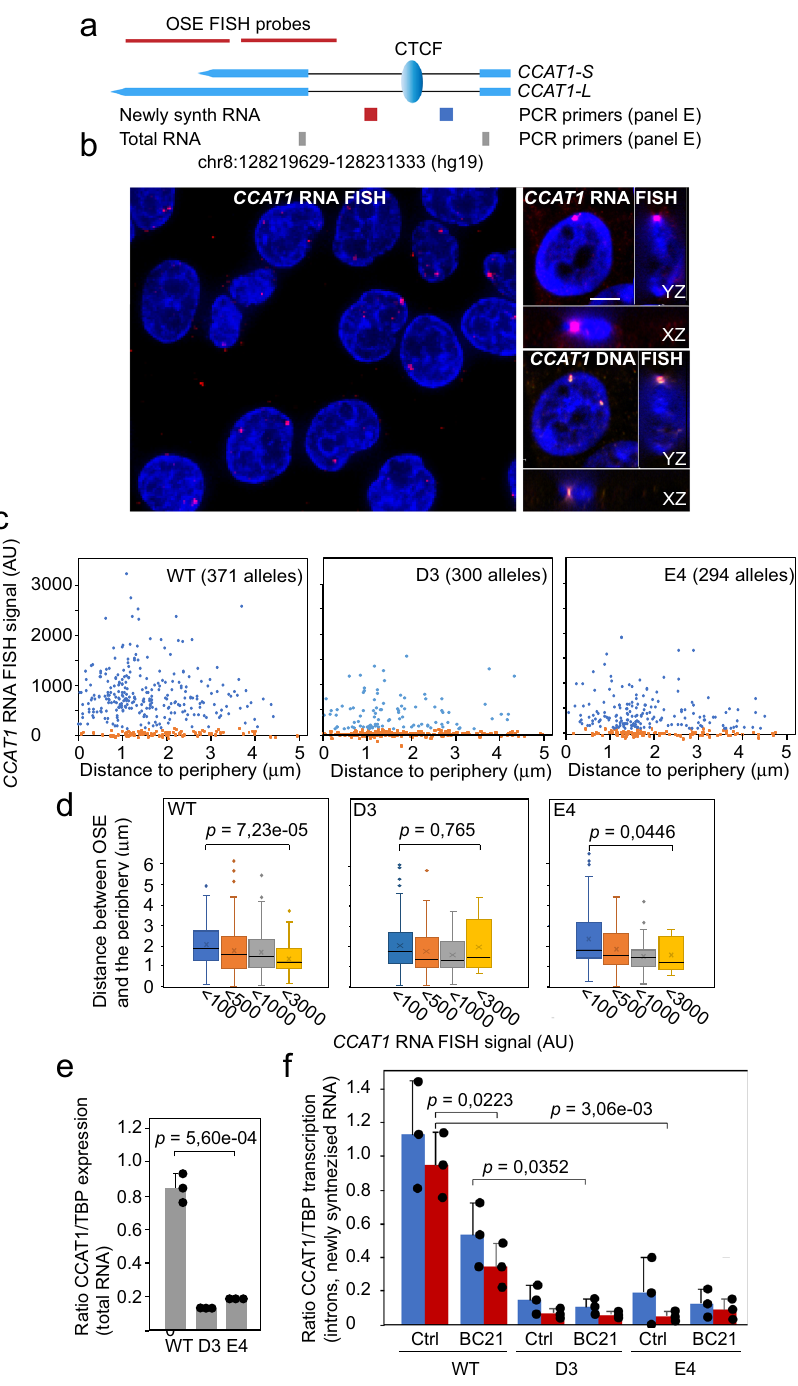
Fig. 6 WNT activates CCAT1 eRNA expression via the CTCFBS to promote its juxtaposition to the nuclear periphery. a Schematic map of the CCAT1 gene and the position of the CTCFBS and the primers used to assess CCAT1 expression. b Sequential RNA/DNA FISH analyses to score for CCAT1 expression in WT HCT-116 cells. The left image shows a larger view with the right image representing a focal plane of CCAT1 RNA and DNA FISH signals. Bar = 3 μ m. c Quantitation of the RNA FISH signals in relation to the nuclear periphery in WT HCT-116 (371 alleles), D3 (300 alleles) and E4 (294 alleles) cells. Data points at or near background (<100 AU) are marked in orange. d Box-and-whisker plots show median values, interquartile ranges and Tukey whiskers ( p values: two-sided KS test) of the distribution of the OSE in relation to the nuclear periphery, strati fi ed according to the strength of the RNA FISH signal. In instances where no RNA FISH signal could be detected above background, the peripheral distribution was determined by the OSE DNA FISH signal. e qRT-PCR analyses of processed CCAT1 eRNA of total RNA using primers marked as gray in ( a ). f qRT-PCR analyses of CCAT1 transcription using newly synthesized (30 min ethynyl-uridine pulse) RNA as templates and primers positioned upstream (blue) or downstream (red) of the CTCFBS, as marked in panel a). The p values indicated in panel d were determined by using the two-sided KS test, whereas the p values shown in ( e , f ) were determined using the two-tailed Student ’ s t